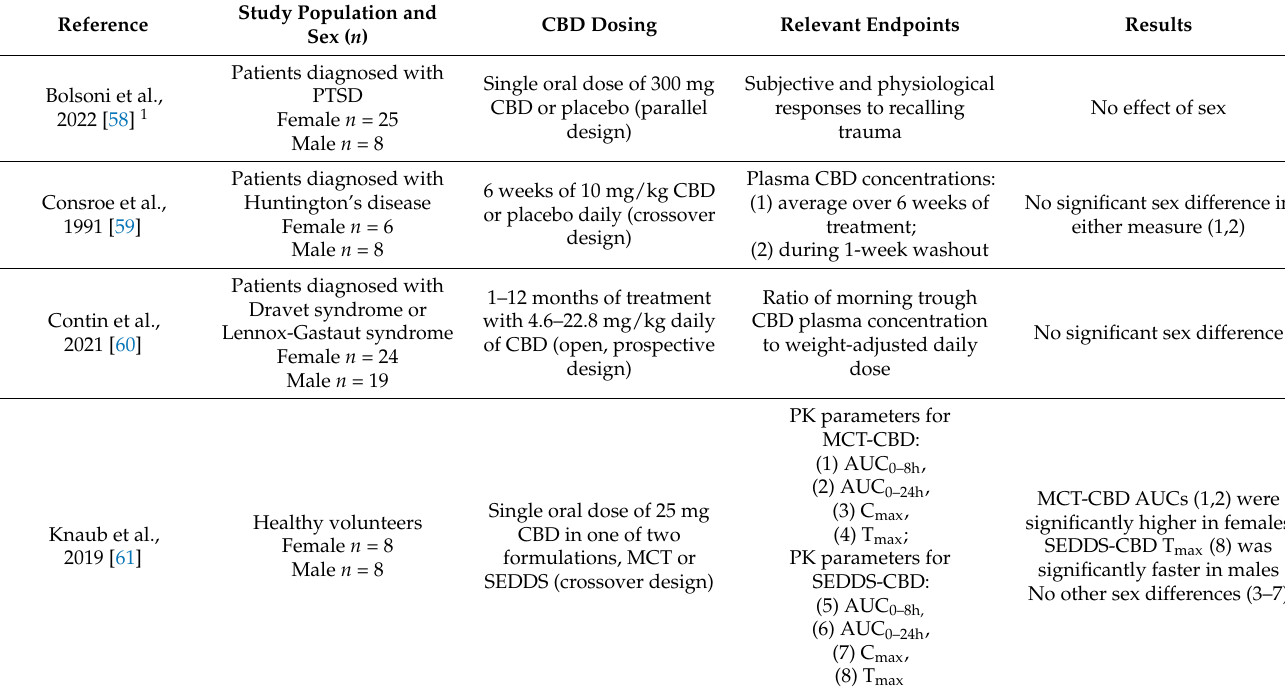
Table 2. Overview of included articles detailing studies in